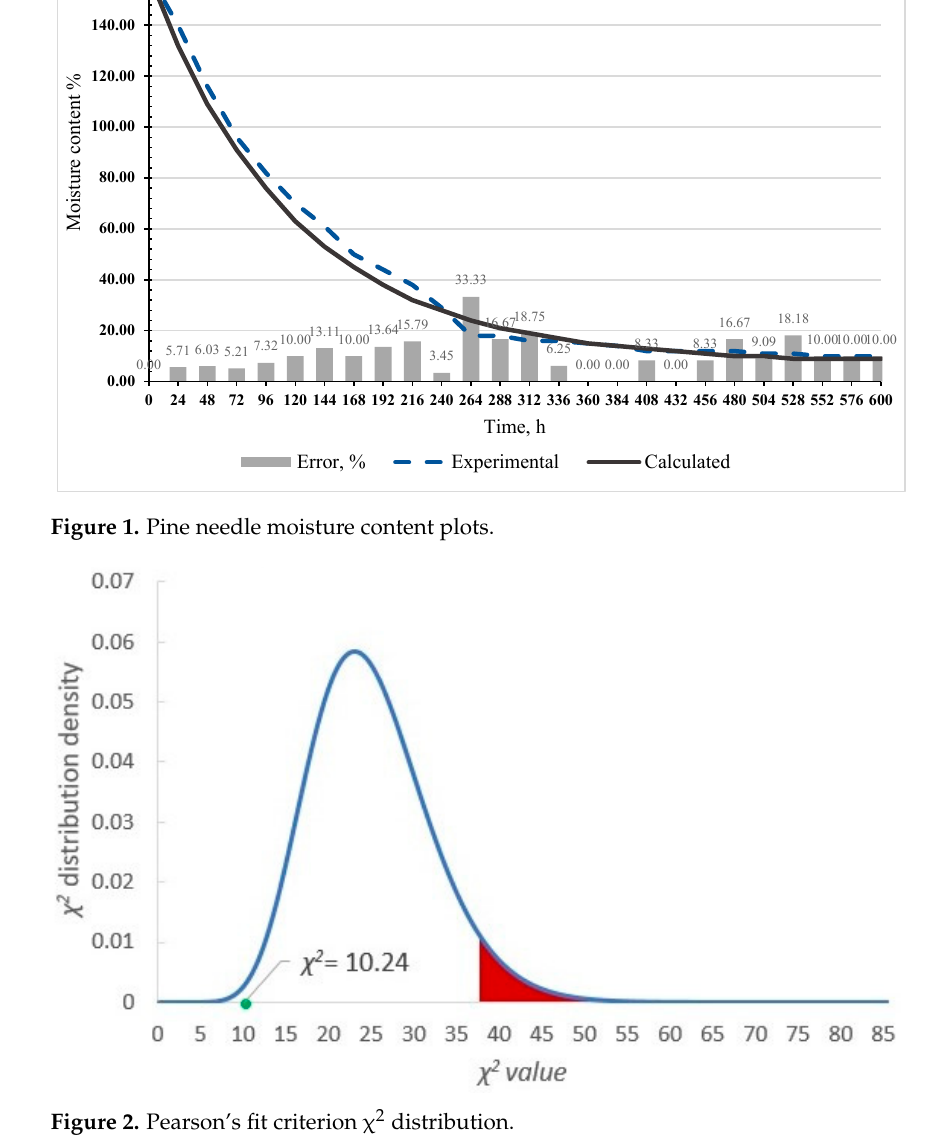
Figure 2. Pearson’s fit criterion χ 2 distribution